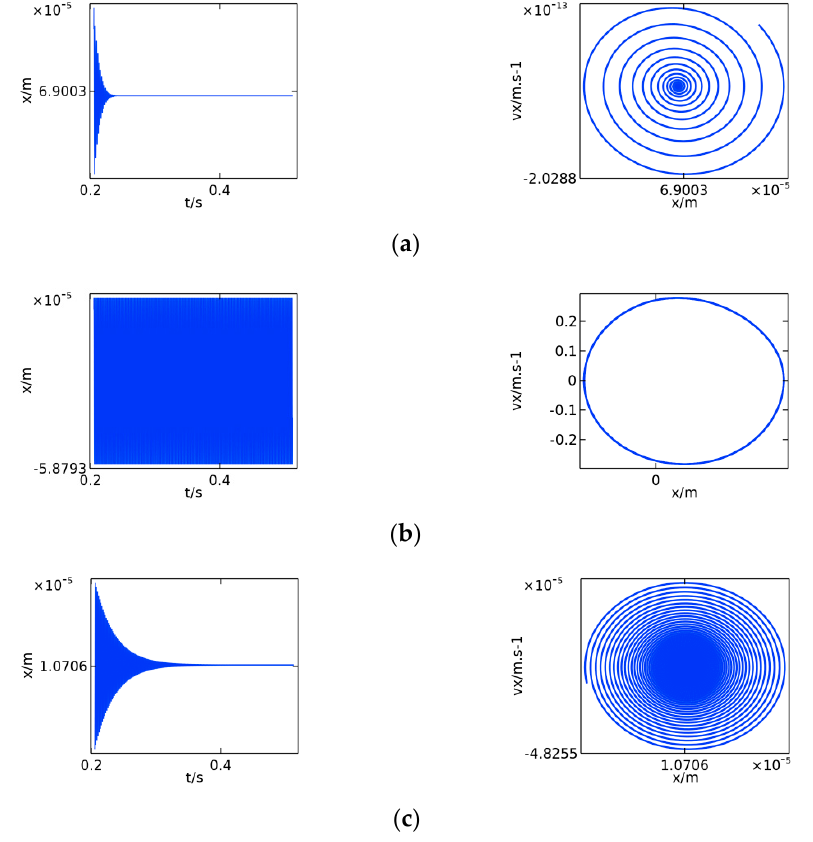
Figure 6. Time domain diagram and phase diagram of wheel vibration at different speeds: ( a ) V = 36 km/h; ( b ) V = 180 km/h; and ( c ) V = 324 km/h.